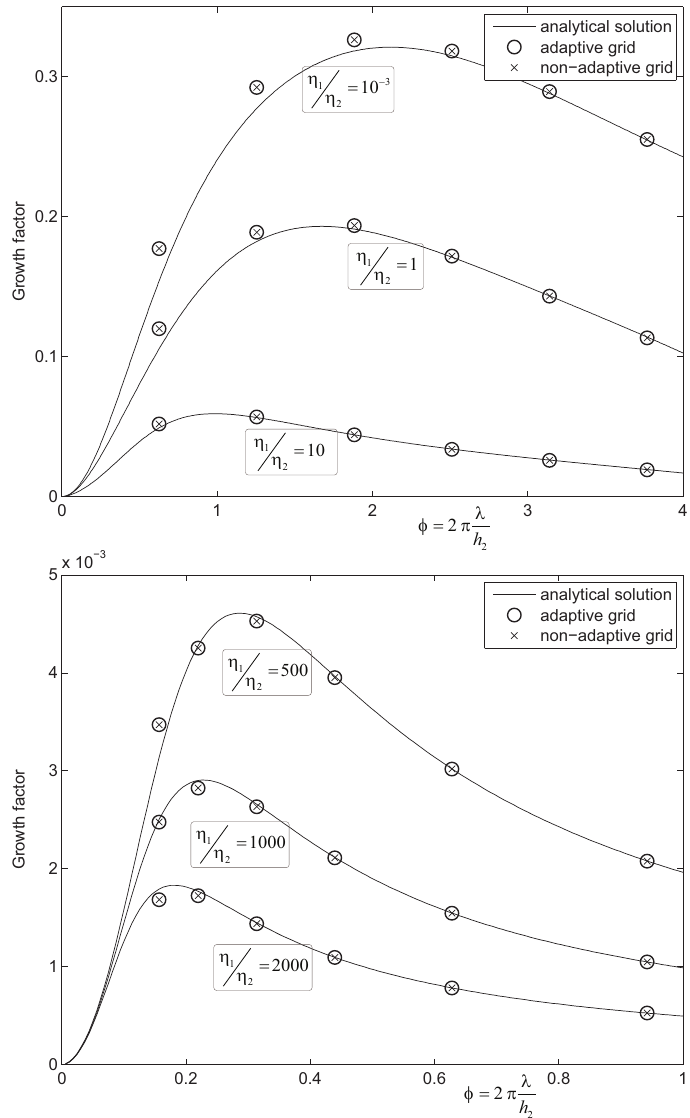
Figure 29. Comparison of numerical and analytical growth rates for Rayleigh-Taylor